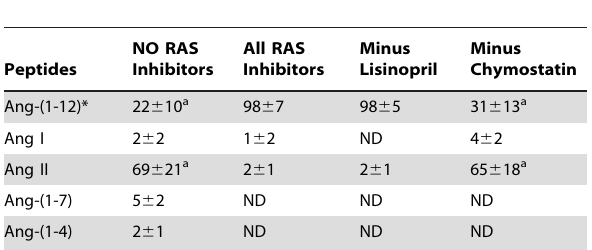
Table 1. Comparative Effects of Selective Enzyme Inhibition on 125 I-Ang-(1-12) Metabolism by plasma membrane isolated from human atrial appendage